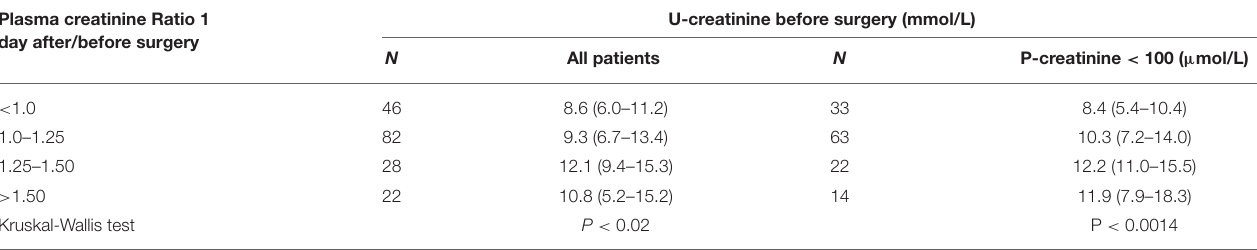
TABLE 3 | The preoperative urine concentrations of creatinine for increasing degrees of perioperative elevations of plasma creatinine. Plasma creatinine Ratio 1 U-creatinine before surgery (mmol/L) day after/before surgery N All patients N P-creatinine < 100 ( µ mol/L) <